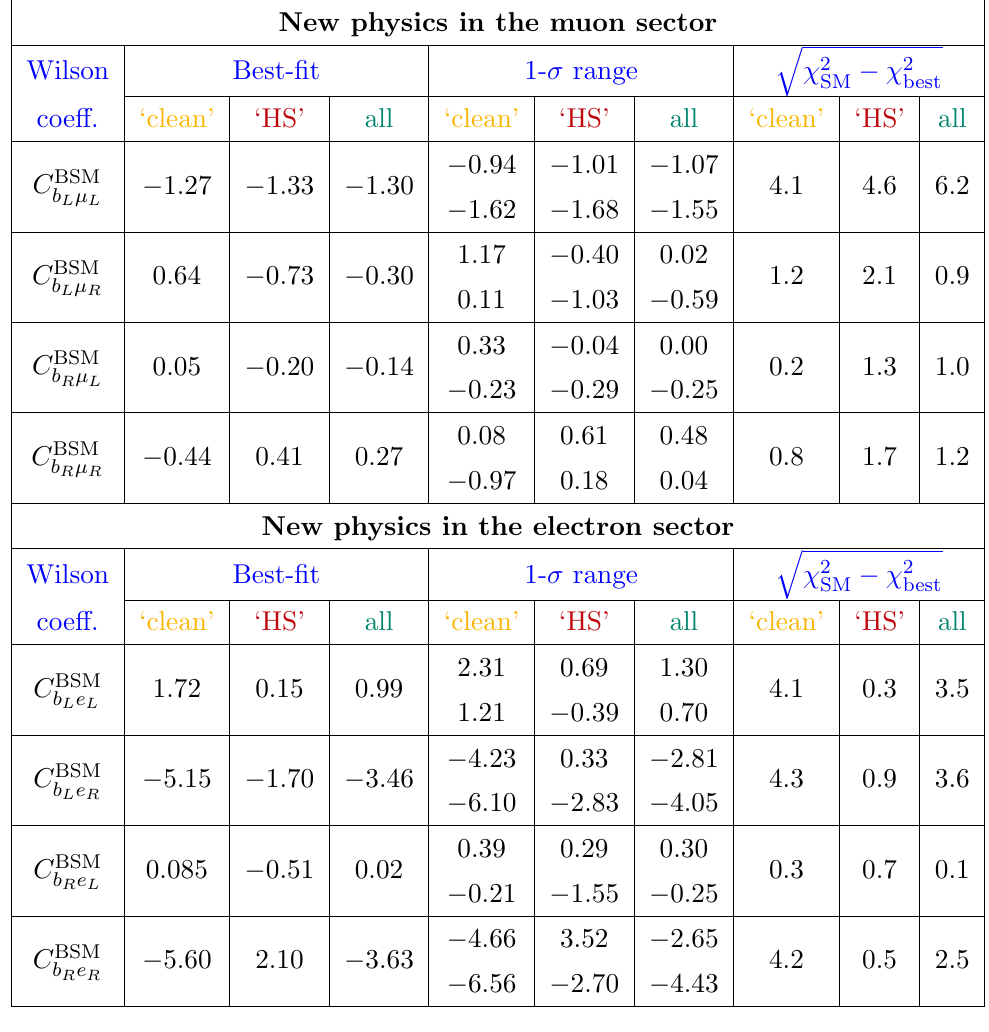
Table 1 . Best (cid:12)ts assuming a single chiral operator at a time, and (cid:12)tting only the ‘clean’ R K , R K (cid:3) , and BR( B s (cid:22) + (cid:22) (cid:0) ), or only the ‘Hadronic Sensitive’ observables (denoted by ‘HS’ in the ! table) as discussed in the text, or combining them in a global (cid:12)t. The full list of observable can be (cid:12)nd in appendix